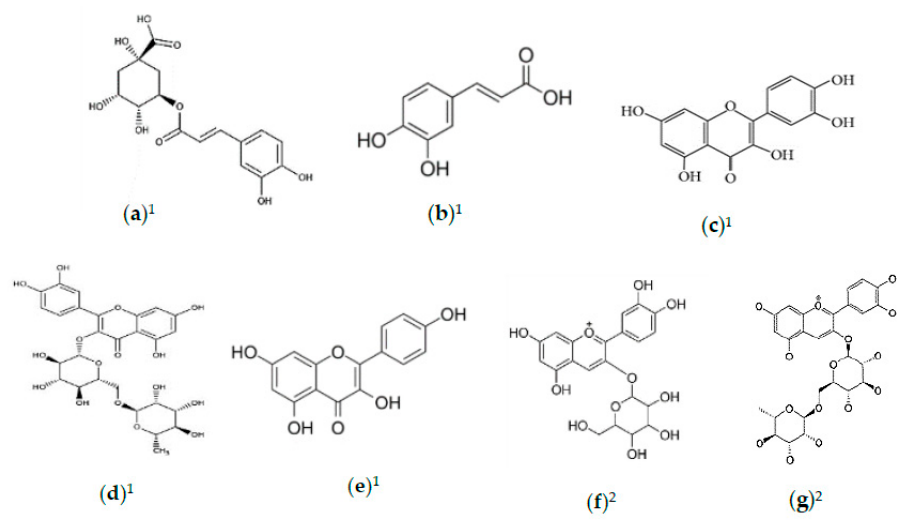
Figure 3. Natural compounds with antihyperlipidaemia activities. ( a ) Chlorogenic acid; ( b ) caffeic acid; ( c ) quercetin; ( d ) rutin; ( e ) kaempferol; ( f ) cyanidin-3-O-glucoside; ( g ) cyanidin-3-O-rutinoside. 1 Refers to compounds in M. alba leaves; 2 refers to compounds in M. alba fruit.